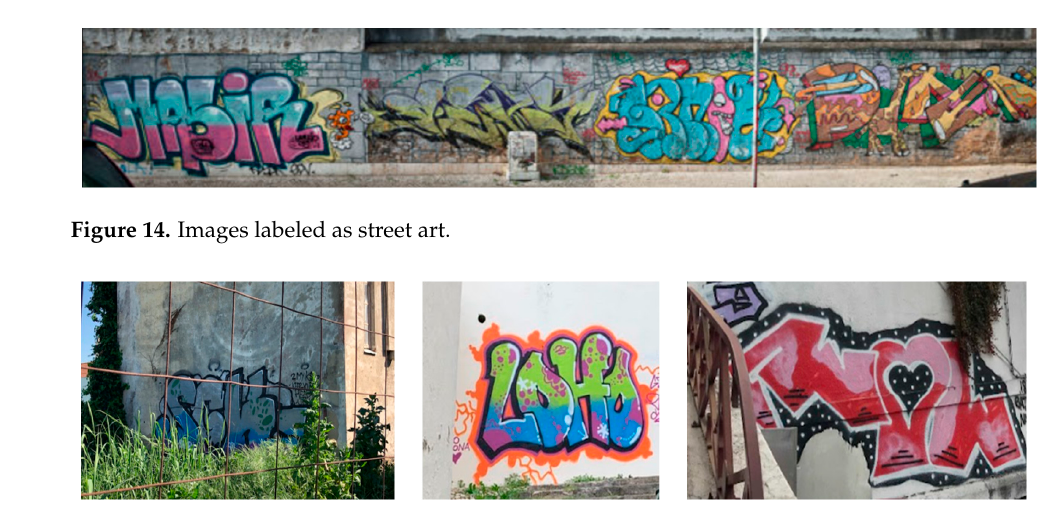
16 of 22 Table 8. Classification metrics for the test set. Metric